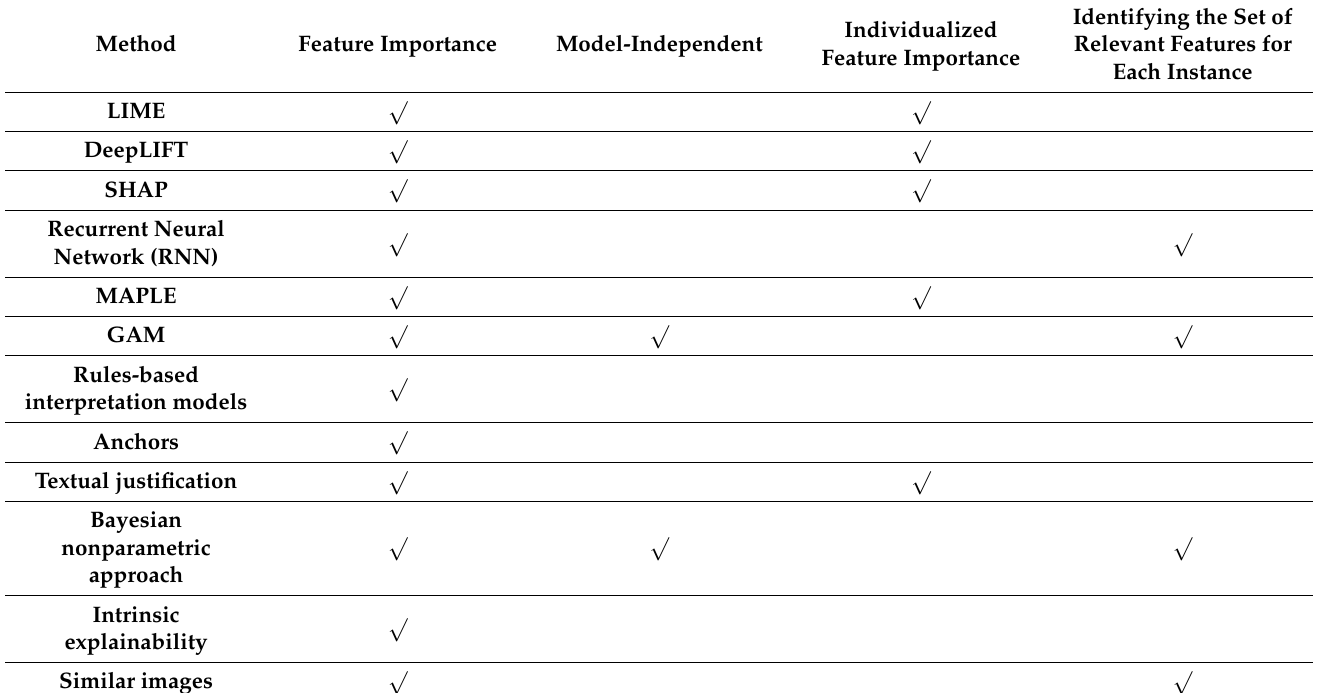
Table 1. The limitations of the existing interpretability